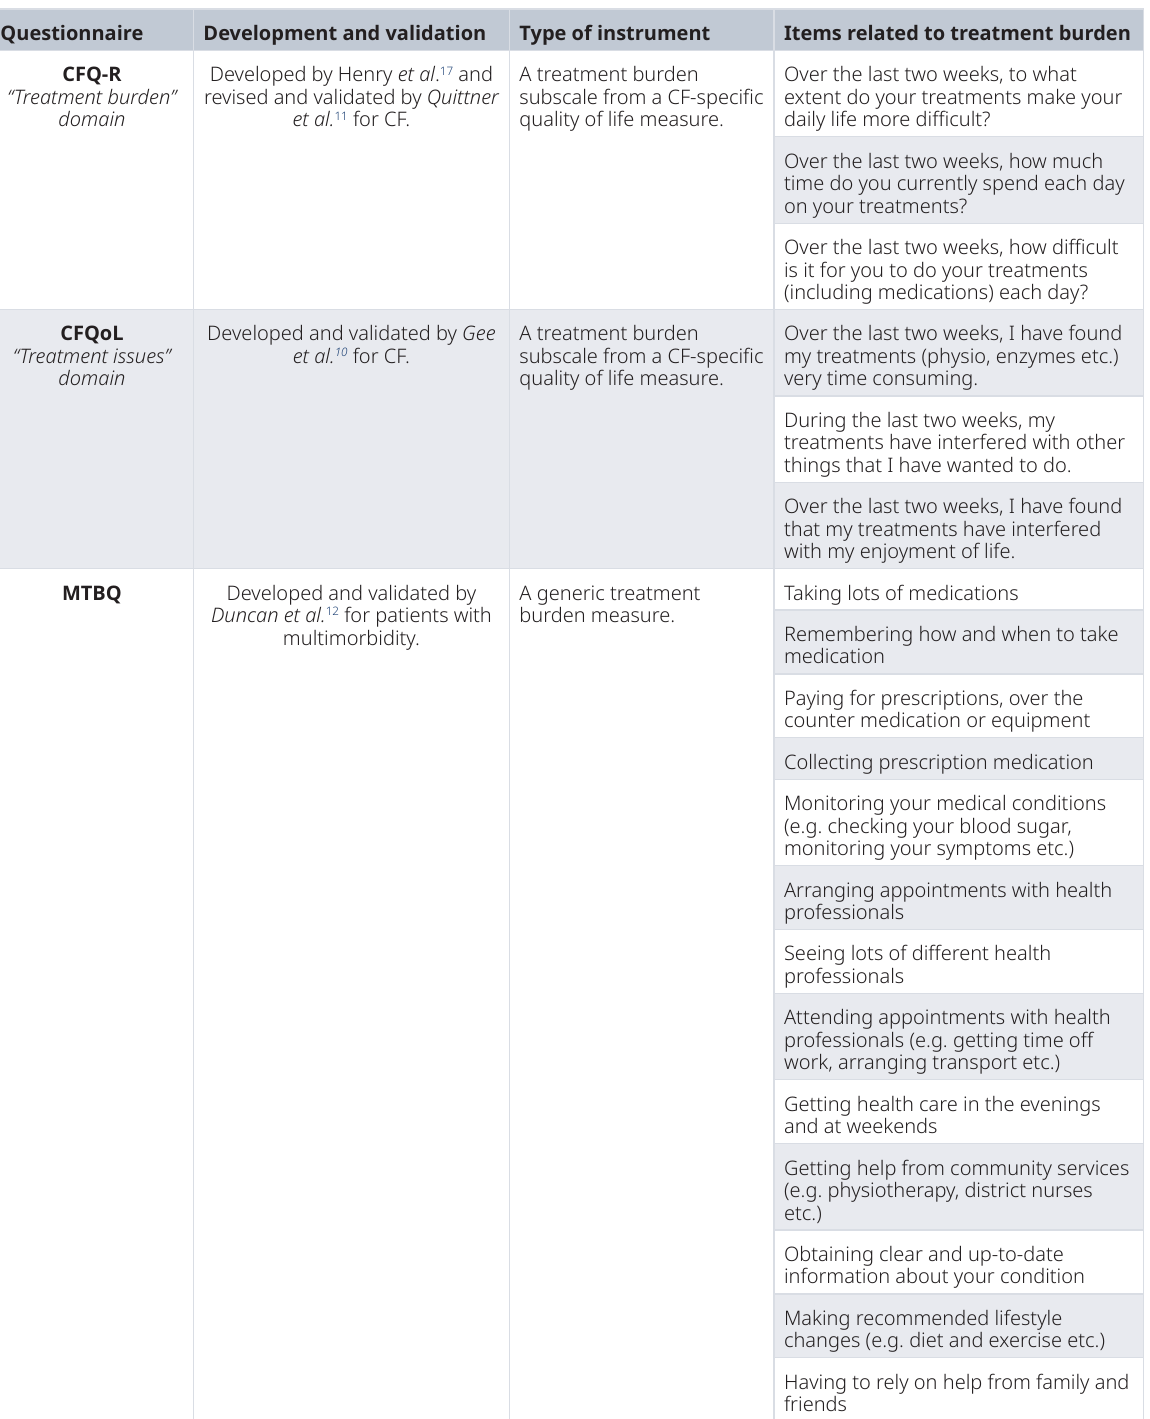
Table 2. Description of the treatment burden measures used in this